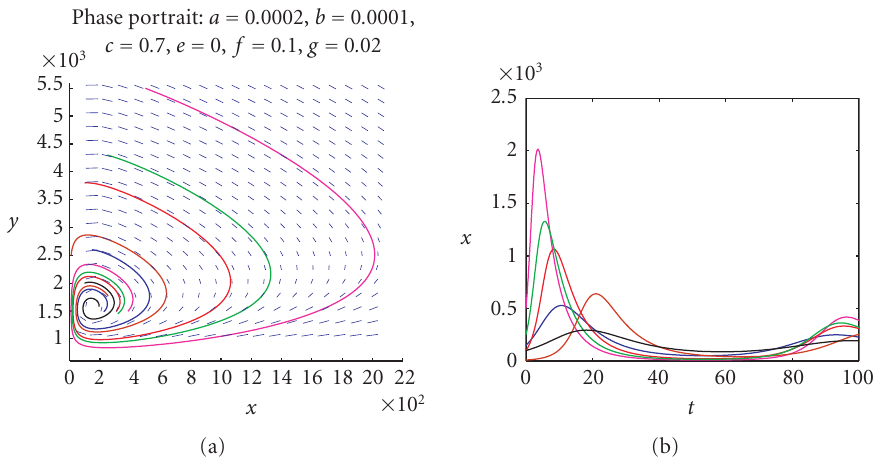
Figure 3.11. A stable spiral is seen when c < 1, A < 0. Note the long time that the trajectory stays in the vicinity of the y -axis and the same parameters used as in Figure 3.3(b) (except for the value of b ). The fixed point occurs at x 0 = 146, y 0 = 1573.